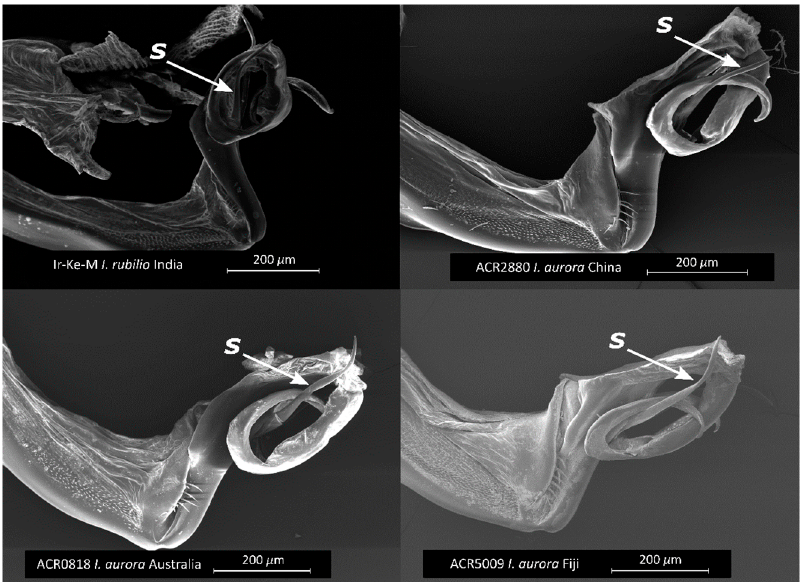
Figure 9. Scanning electron images showing the male genital ligula of Ischnura rubilio from India and I. aurora from China, Australia, and Fiji. The arrows in each image point to the spine ( s ) proximal to the genital ligula flexure, typical of most Ischnura species.